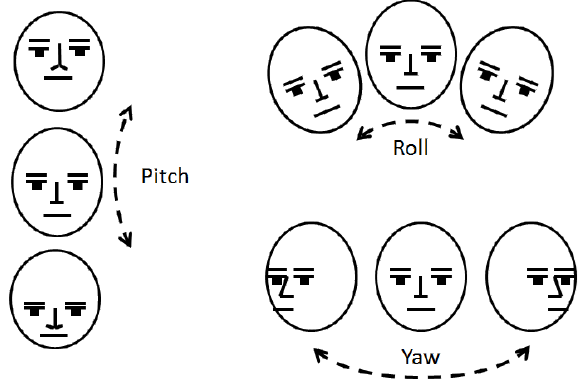
Figure 1. Three different degrees of freedom: pitch, roll and yaw [14]. All head motion can be obtained by combining these three basic